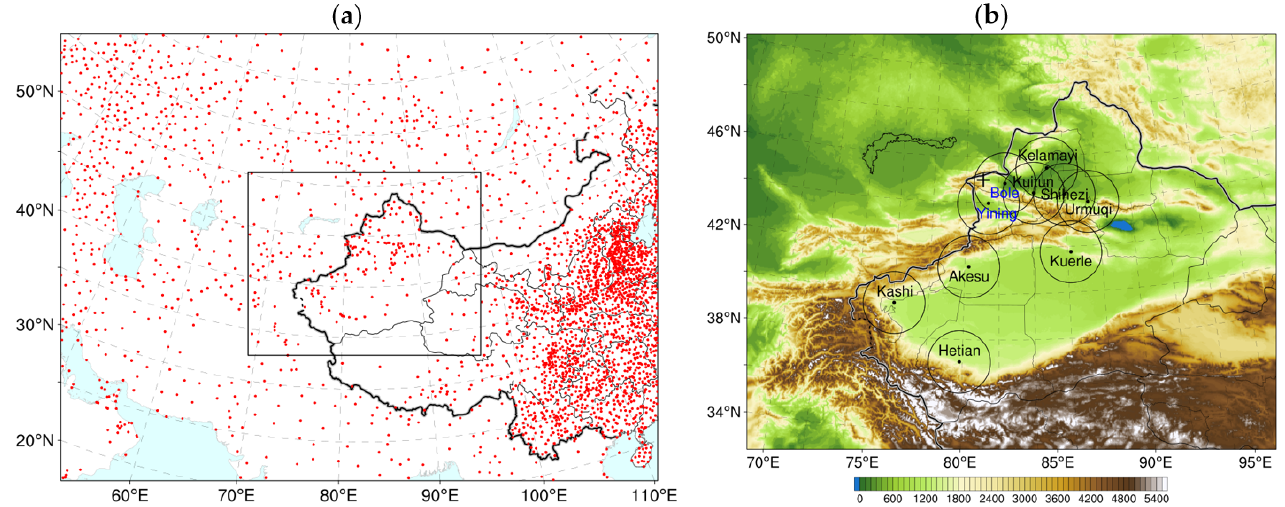
Figure 2. ( a ) The model forecast domains and observations assimilated. The outside box indicates domain 1, and the inner black box indicates domain 2. The red dots indicate SYNOP stations. ( b ) The radar station and radar data assimilated available range in domain 2. The location of Wenquan national meteorological station, west of Bole’s radar, is represented by the back cross marker which is same below. The black dots show the locations of the nine radar stations. The altitude (unit m) of ground above sea level is represented by the colour shades.